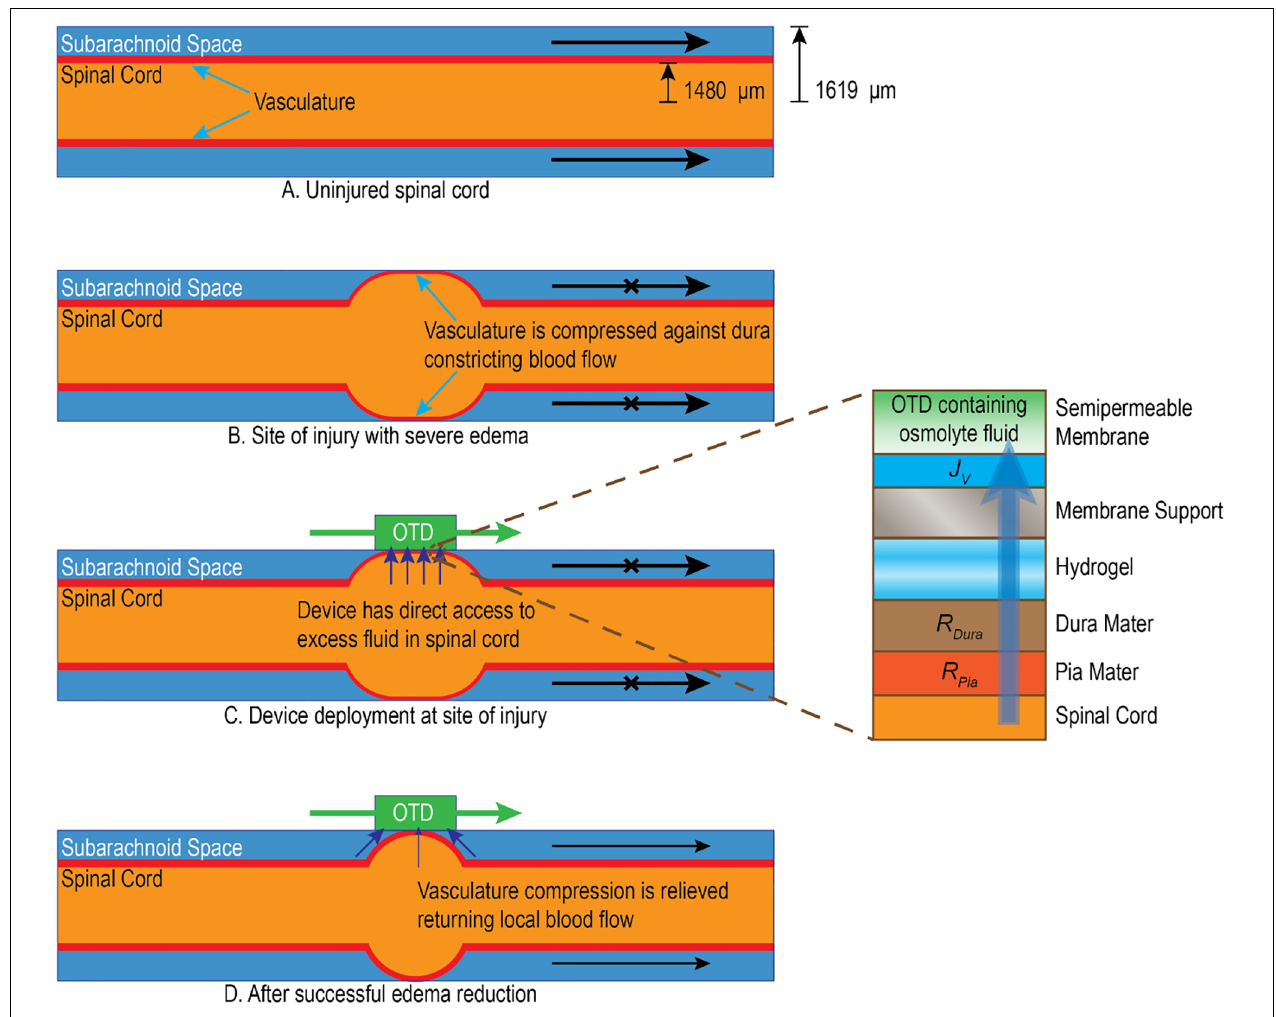
FIGURE 1 | Simplified illustration of how edema impacts local spinal cord environment and the potential mechanism of action for the OTD. (A) Uninjured tissue has unobstructed vasculature and cerebrospinal fluid (CSF) in the subarachnoid space. (B) After injury, severe edema emanates from the central location of the spinal cord and forces tissue against the dura mater. This constricts local blood vessels in the subarachnoid space (illustrated as red) as well as reduces CSF movement in the local region (Saadoun and Papadopoulos, 2020). (C) The OTD is placed at the point of injury directly on the dura mater. Hydrogel is used to maintain a continuous aqueous interface. The OTD uses osmotic pressure to gently remove water across the permeable tissue (through the cord tissue, pia mater, and dura mater). (D) In time, the OTD may reduce the water content of the swollen tissue to alleviate pressure and constriction of the vasculature and allow fluid movement in the subarachnoid space. Estimates of typical tissue radii with cylindrical approximations for adult rat spinal cord are shown in panel (A) and are derived from the literature (Soubeyrand et al.,